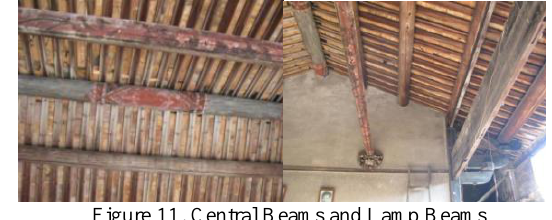
Figure 11. Central Beams and Lamp